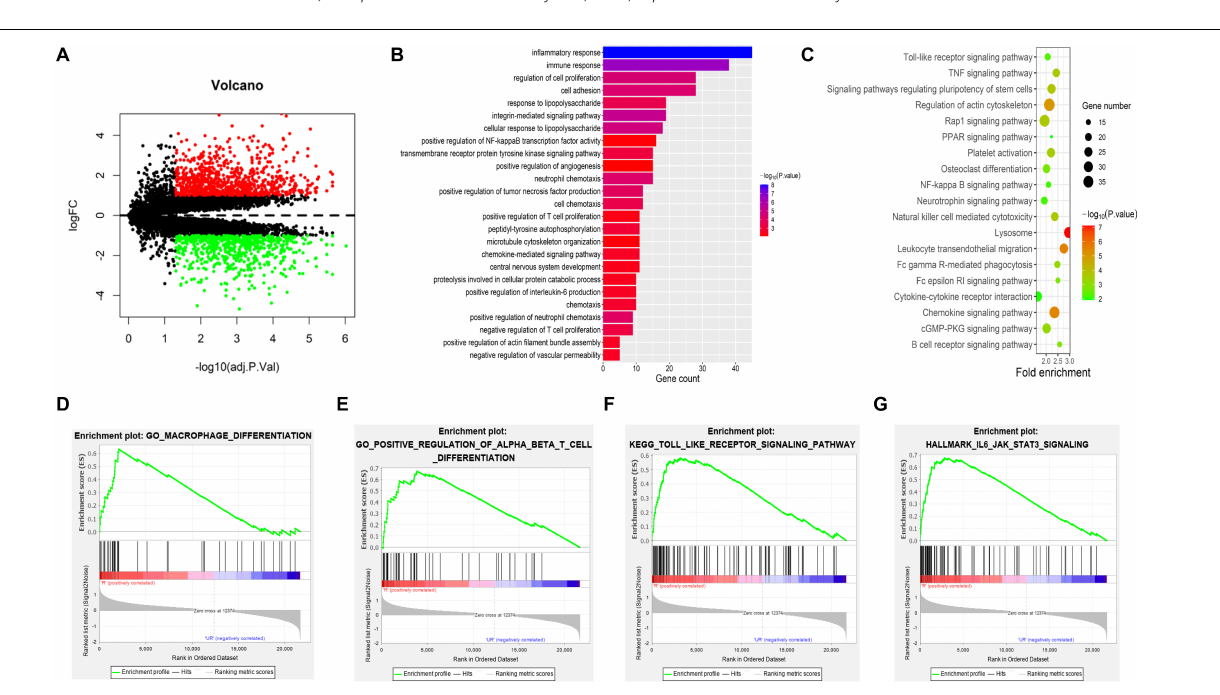
FIGURE 1 | DEG and functional enrichment analyses. (A) Volcano plot of DEGs in IAs [ p < 0.05 and log2| (fold change)| > 1] in the GEO IAs transcriptional profiles. There were 11 UIAs and 13 RIAs. (B–G) Visualization of the enrichment results. (B) GO terms are colored by the p value, and terms containing more genes tended to have a more significant p value. (C) KEGG pathway terms are colored by the p value, and terms containing more genes tended to have a larger size. (D–G) GSEA results show that macrophage differentiation, positive regulation of alpha beta T-cell differentiation, Toll-like receptor signaling pathway, and IL6–JAK–STAT3 pathway were enriched in RIAs compared with UIAs. DEGs, differentially expressed genes; GEO, Gene Expression Omnibus; IAs, intracranial aneurysms; UIAs, unruptured intracranial aneurysms; RIAs, ruptured intracranial aneurysms; GO, Gene Ontology; KEGG, Kyoto Encyclopedia of Genes and Genomes; GSEA, gene set enrichment